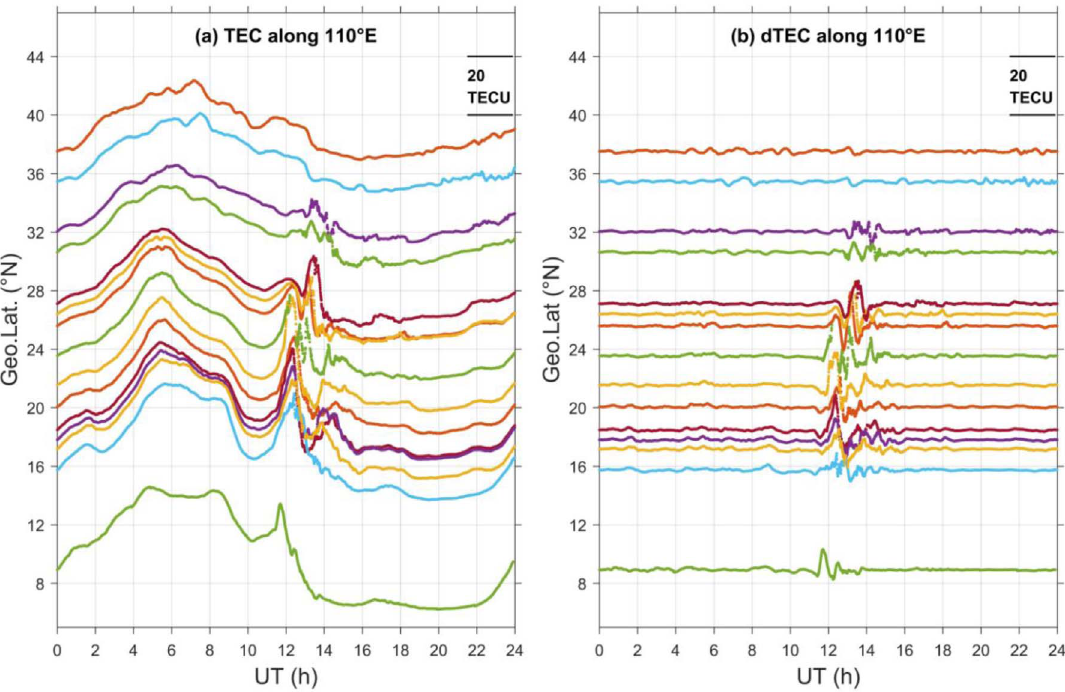
Fig. 6. (a) TEC and (b) dTEC obtained from Beidou geostationary satellites along 110 (cid:3) E on 15 January 2022. Each TEC and dTEC curve was offset by the corresponding latitude of the ionospheric pierce